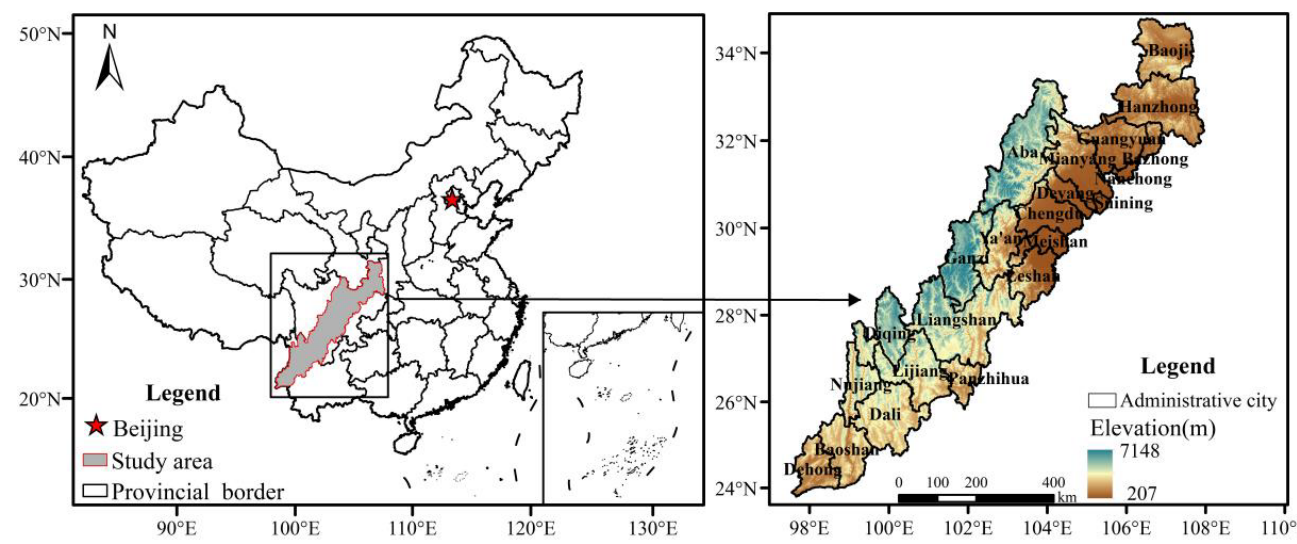
Figure 1. Location of Sichuan-Yunnan Ecological Barrier in China.